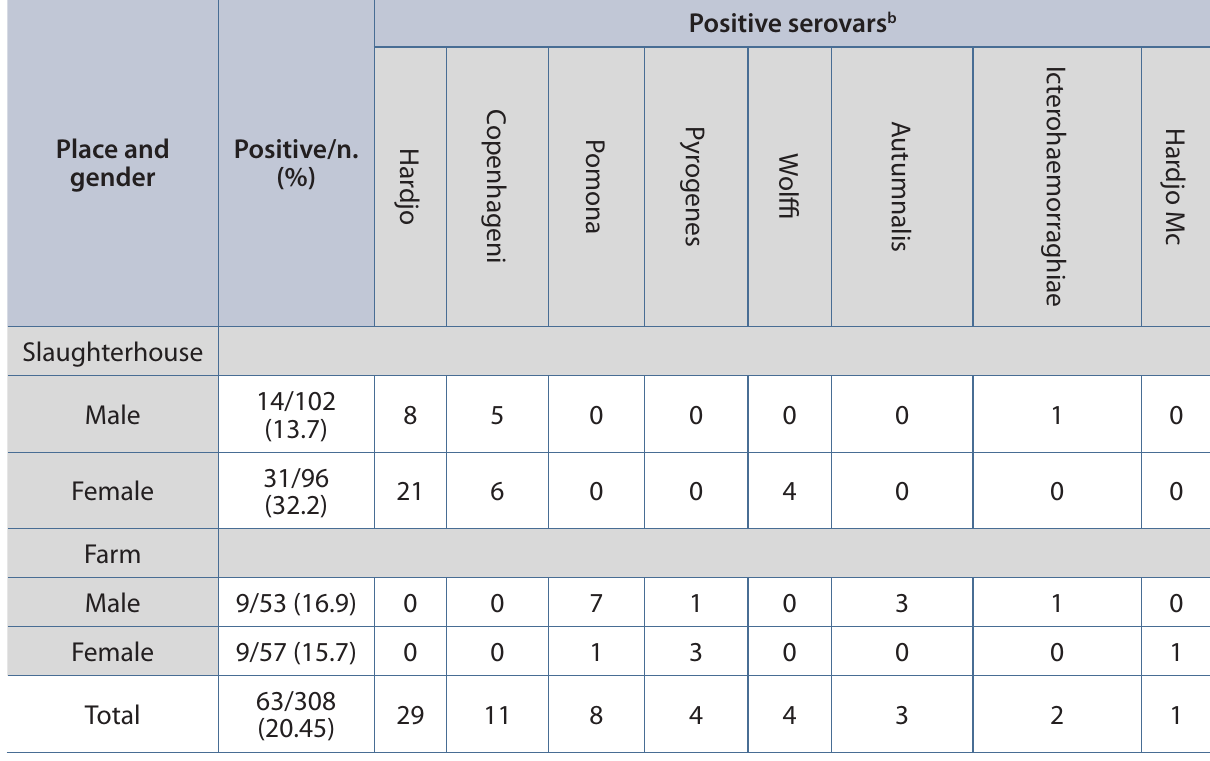
Table 1. Distribution of Leptospira spp. antibodies in wild boars ( Sus scrofa ) bred in Brazil